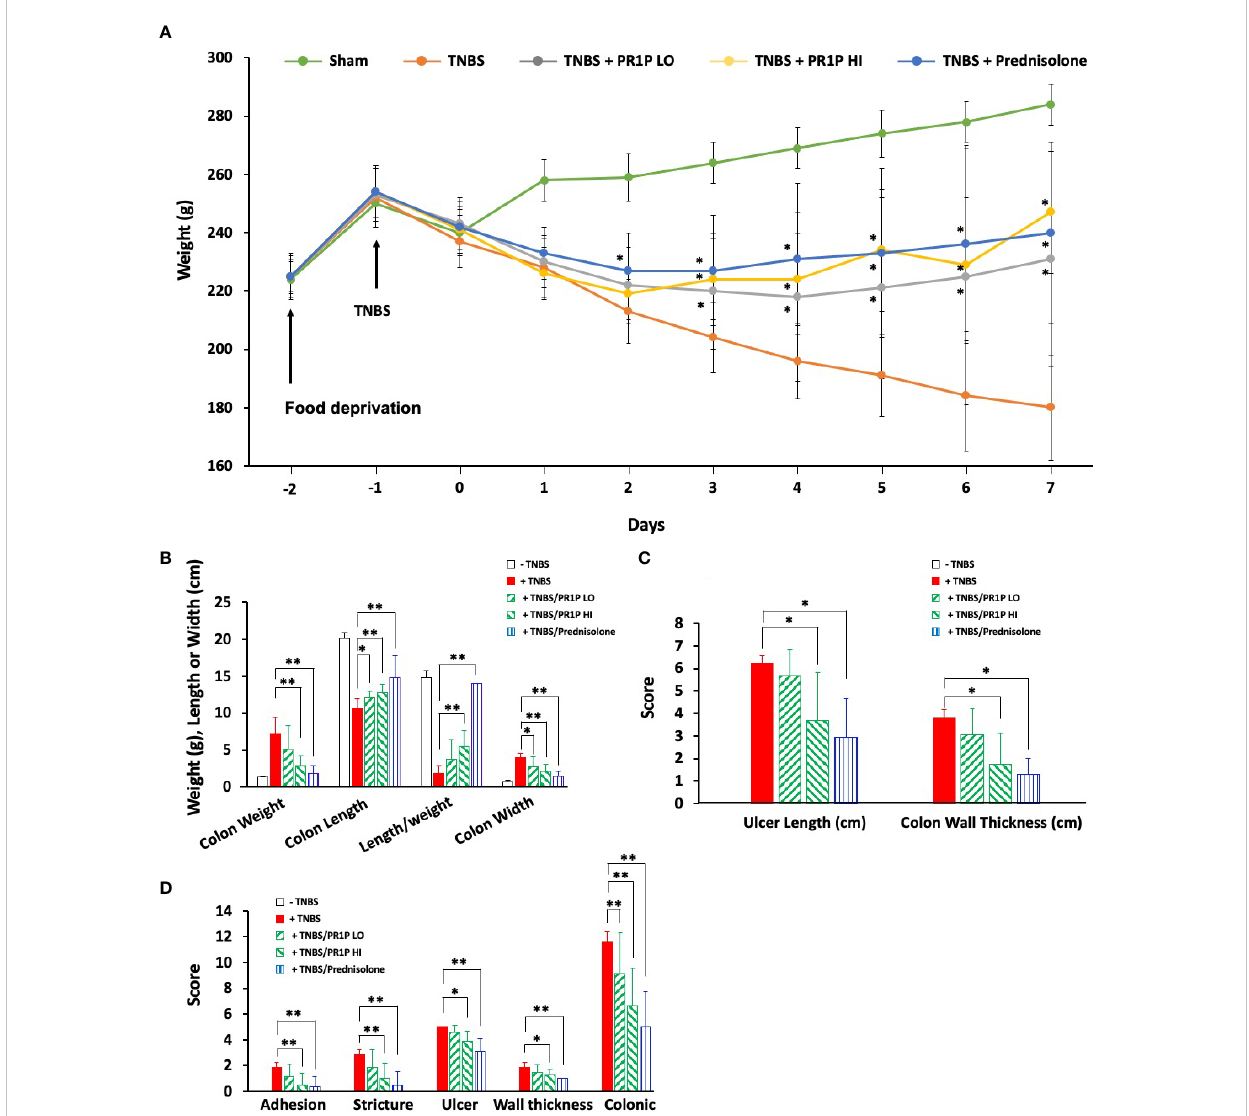
FIGURE 3 PR1P improves disease outcome parameters in TNBS-induced colitis in rats. (A) Line graph showing average daily weights of rats treated with daily low-dose PR1P (0.5 mg/kg IP, TNBS + PR1P LO) or high-dose PR1P (5 mg/kg IP, TNBS + PR1P HI) or prednisolone (10 mg/kg po, TNBS + Prednisolone) following induction of colitis from administration of intra-rectal TNBS. Sham animals received intra-rectal 50% ethanol (vehicle) to induce colitis and no treatments. TNBS group (+TNBS) received daily treatment with vehicles IP or po. *p<0.001 vs +TNBS group. (B-D) Bar graphs showing average colon weight, colon length, length/weight ratio and colon wall thickness (B) , *p<0.03, **p<0.004), ulcer length and colon wall thickness ( C , *p<0.005) and average scores for adhesions, strictures, ulcer, wall thickness and colonic score using scoring system described in methods ( D , *p<0.05, **p<0.009) from indicated treatment groups at the end of experiments described in (A) . Data in (A-D) are mean ± SEM. n=8 animals per